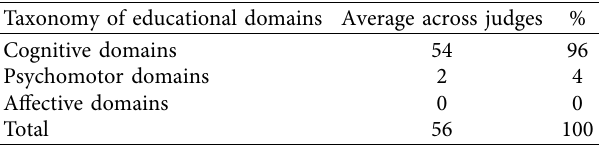
Table 1: Categorization of syllabus objectives into the taxonomy of educational